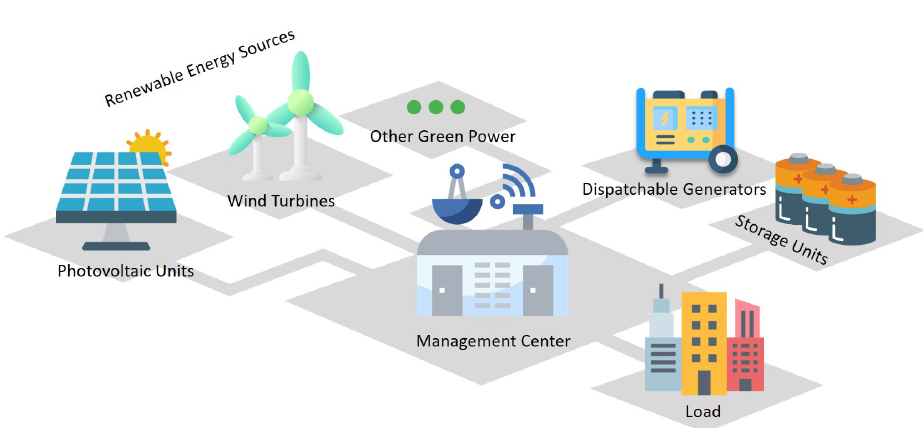
Figure 1. The system model of general isolated microgrids.